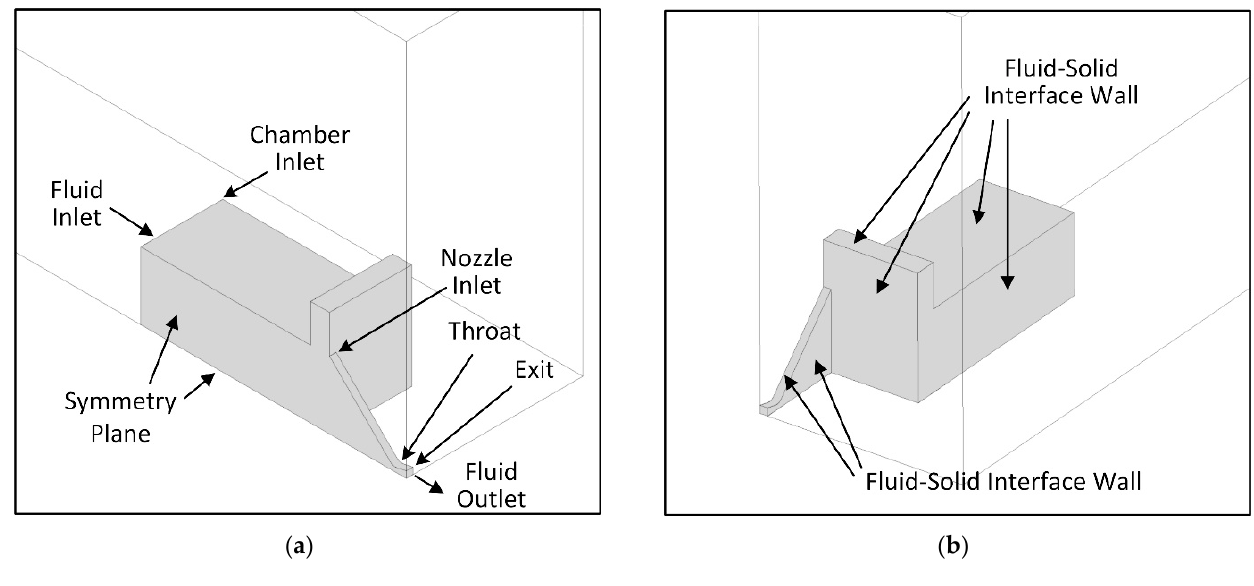
Figure 4. Microthruster boundary conditions for the simulation. ( a ) Fluid domain—left side view. ( b ) Fluid domain—right side view.